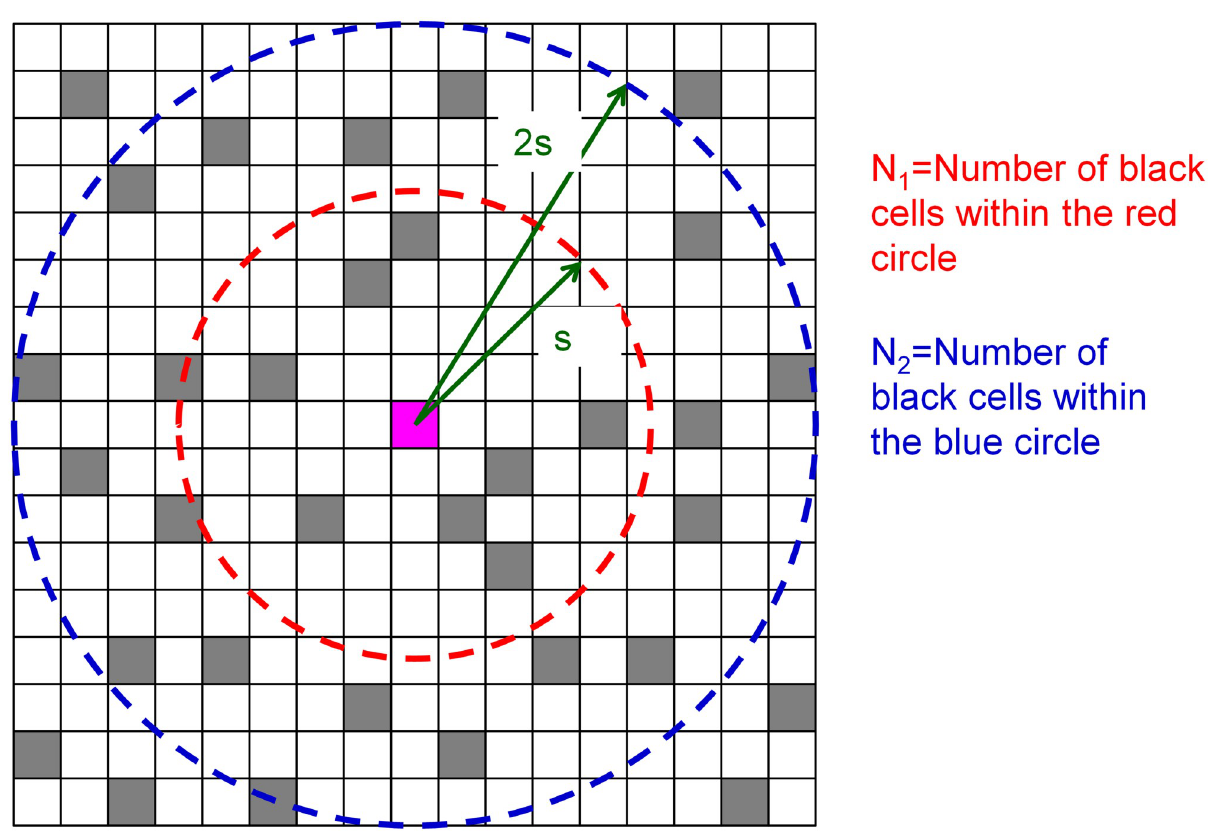
Fig 3. Schematic diagram of the summation of states N 1 and N 2 . Each grid cell has state 0 (white) or 1 (black). The inner area has a domain within the s grid of the focal cell, and the outer area has a domain within the 2s grid.